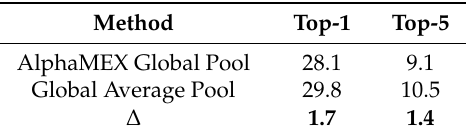
Table 3. Experiments on ImageNet. ResNet architecture is used to compare AlphaMEX Global Pool and global average pool. Top-1 error rate (%) and top-5 error rate (%) are both shown. The difference in error rates is indicated by “ ∆